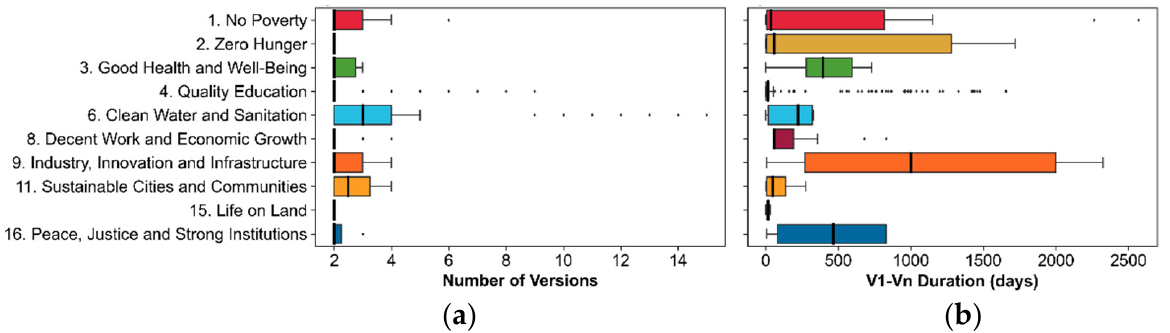
Figure 16. ( a ) The frequency of terminal version numbers (Vn), and ( b ) the total duration between V1 (creation) and Vn (terminal version) dates for SDG data in non-refugee settlements. Interquartile range (25–75%) shown in colored boxes, median value shown as thick black line, whiskers extend to an IQR value 150% below Q1 or over Q3 to show the minimum and maximum respectively, and outlier values are shown as single dots.